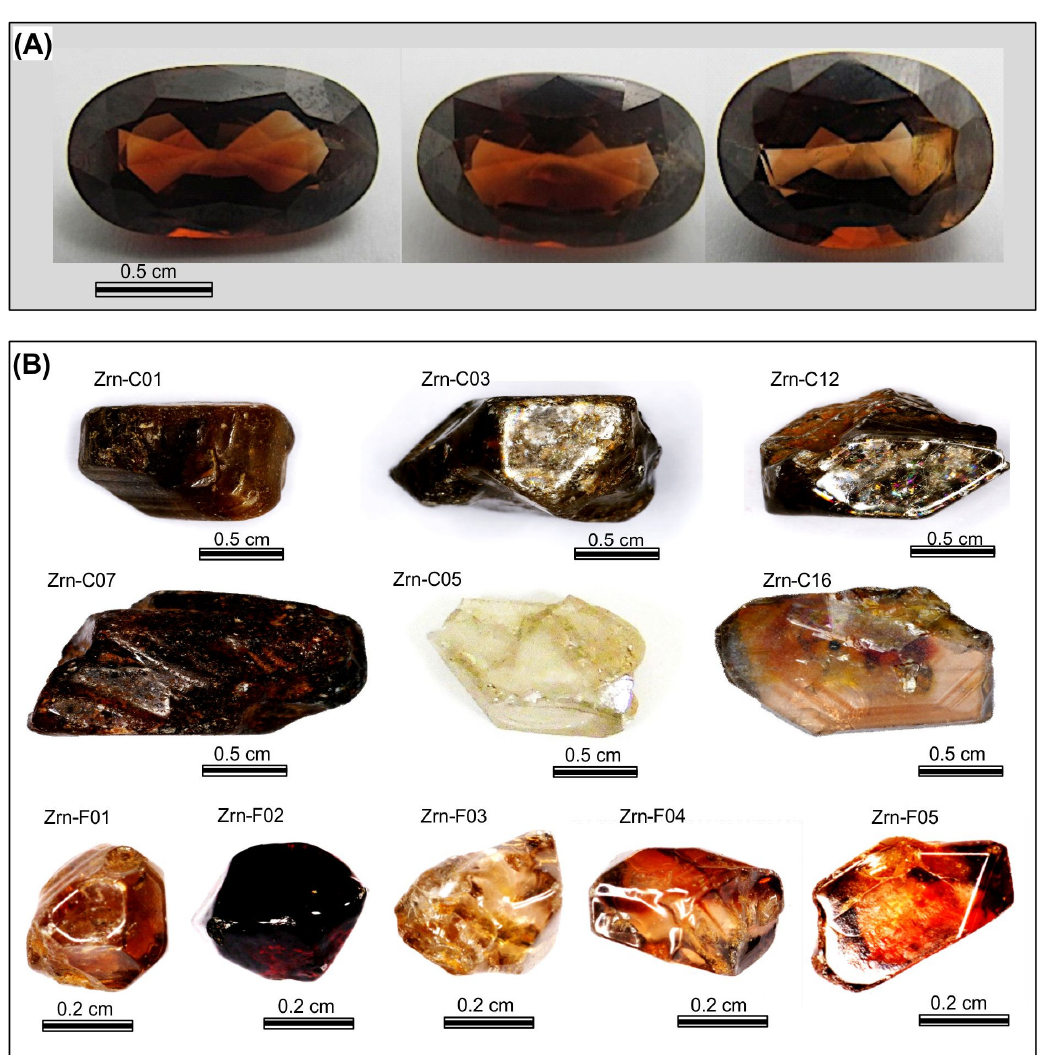
Figure 2. ( A ) Typical large, gem-quality, cut zircon samples from the Central Highlands are available on the gem market. ( B ) Selected zircon megacrysts used in this study from the same region. Samples C05, C07, and C16 are from the Buon Ma Thuot and Xuan Loc alkali-basaltic field. Samples DL1, DL2, and DL3 (not shown) are from deposits in the Dak Lak alkali-basaltic field (Figure 1B).